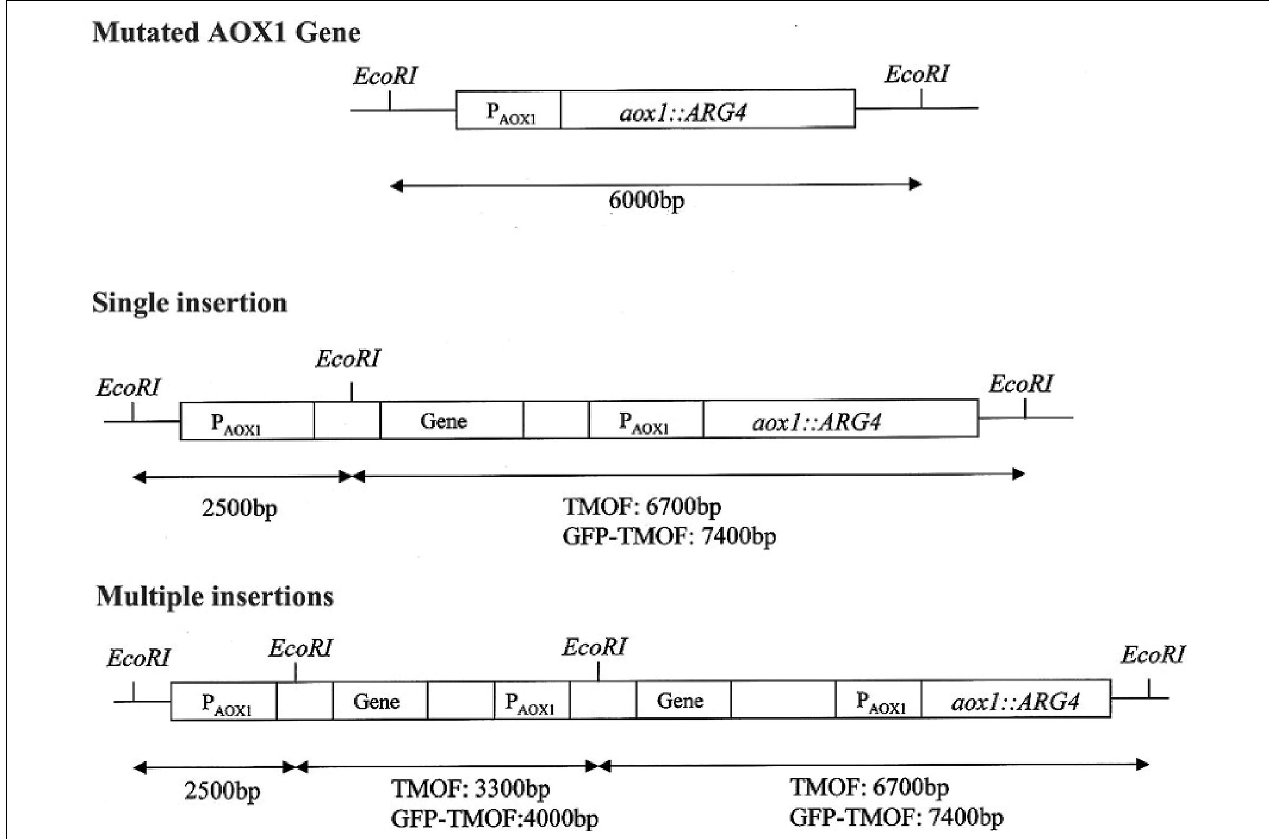
FIGURE 3 | Genetic map of KM71 and KM71H cells with mutation at the aox 1 and its promoter showing the DNA size and Eco RI restriction sites. A genetic map after a single insertion of tmf A and gfp-tmf A including Eco RI restriction sites and expected restriction fragments after Eco RI digestion. A genetic map of multiple insertion of tmf A and gfp-tmf A including additional Eco RI sites and restriction